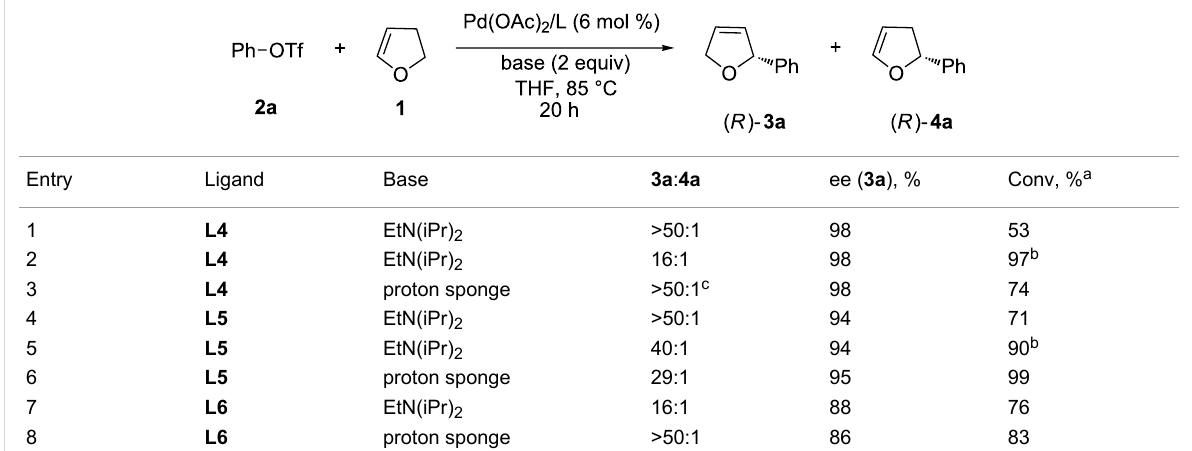
Table 3: Screening of L4 – L6 in the asymmetric Heck arylation